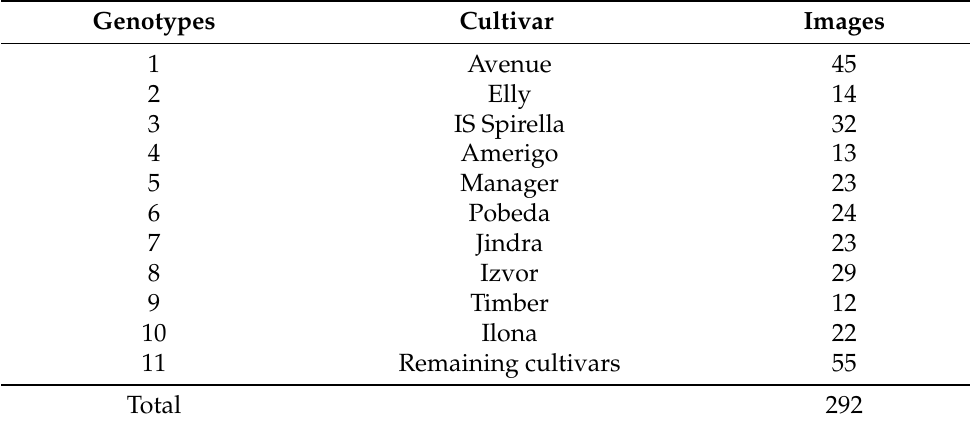
Table 2. Overview of 19 Central European wheat cultivars used in this study for training and the evaluation of detection and segmentation methods. The remaining cultivars (nine) corresponding to genotype 11 include Pannonia NS, Tobak, Stephens, Cubus Bohemia, Midas, Genius, Fakir, Turandot, and Frisky.